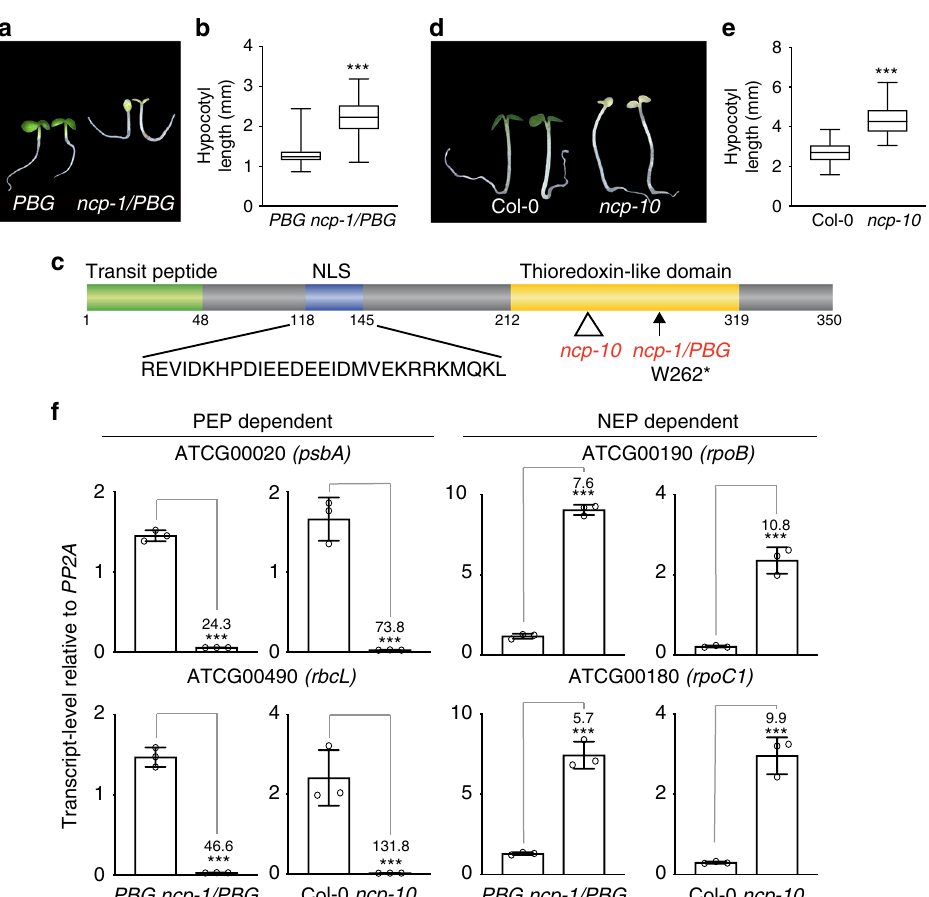
Fig. 1 Identi fi cation of NCP by a screen for tall-and-albino mutants. a Representative images of 4-day-old PBG and ncp-1/PBG seedlings grown in 10 μ mol m − 2 s − 1 continuous R light. b Box-and-whisker plots showing hypocotyl measurements of the seedlings in a . c Schematic illustration of the predicted domain structure of NCP. The mutation in ncp-1/PBG and the T-DNA insertion site in ncp-10 are indicated. NLS, nuclear localization signal. d Representative images of 4-day-old Col-0 and ncp-10 seedlings grown in 10 μ mol m − 2 s − 1 continuous R light. e Box-and-whisker plots showing hypocotyl measurements of the seedlings in d . f qRT-PCR results showing the steady-state mRNA levels of the PEP-dependent psbA and rbcL and the NEP-dependent rpoB and rpoC1 in 4-day-old PBG , ncp-1/PBG , Col-0, and ncp-10 seedlings grown in 10 μ mol m − 2 s − 1 continuous R light. Error bars represent SD of three biological replicates. The transcript levels were calculated relative to those of PP2A . The numbers above the right columns are the fold changes in gene expression between the columns. For the box-and-whisker plots in b and e , the boxes represent from the 25th to the 75th percentiles, and the bars equal the median values. For b , e , and f , asterisks (***) indicate a statistically signi fi cant difference between the values of the mutants and those of the wild-type or the parental line (Student ’ s t -test, p ≤ 0.001). The source data of the hypocotyl measurements in b , e and the qRT-PCR data in f are provided in the